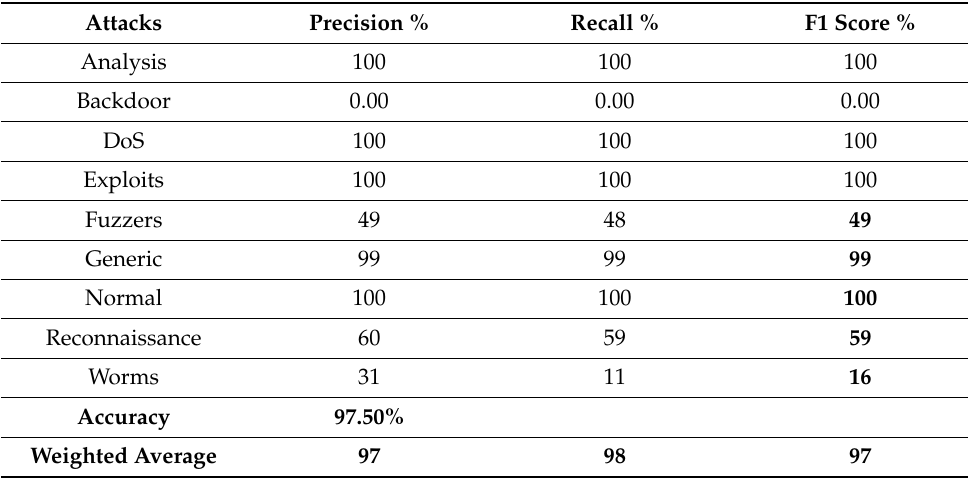
Table 7. Results of RF on multi-classification.